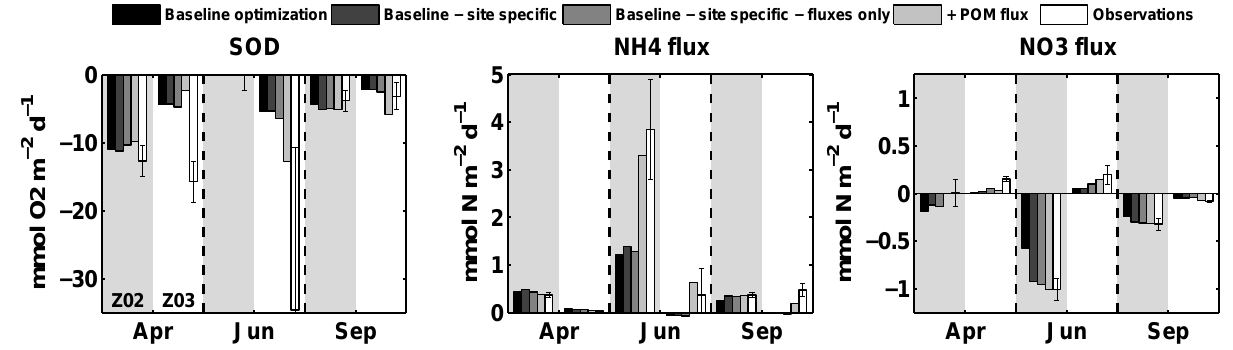
Figure 4. Model–data comparison of sediment–water fluxes at stations Z02 and Z03 for several different optimization schemes (baseline includes all